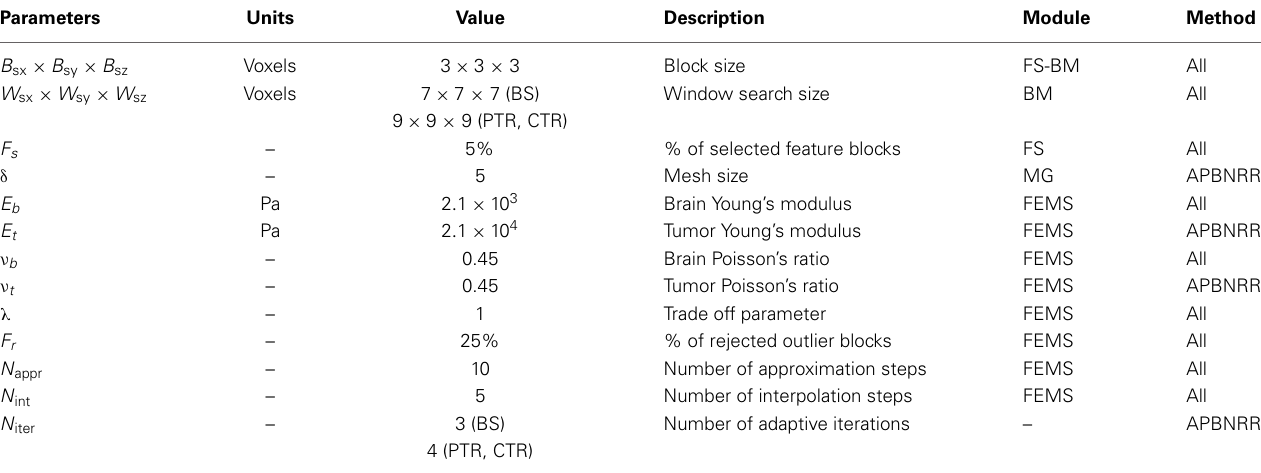
Table 3 | The input parameters for the 14 clinical cases.